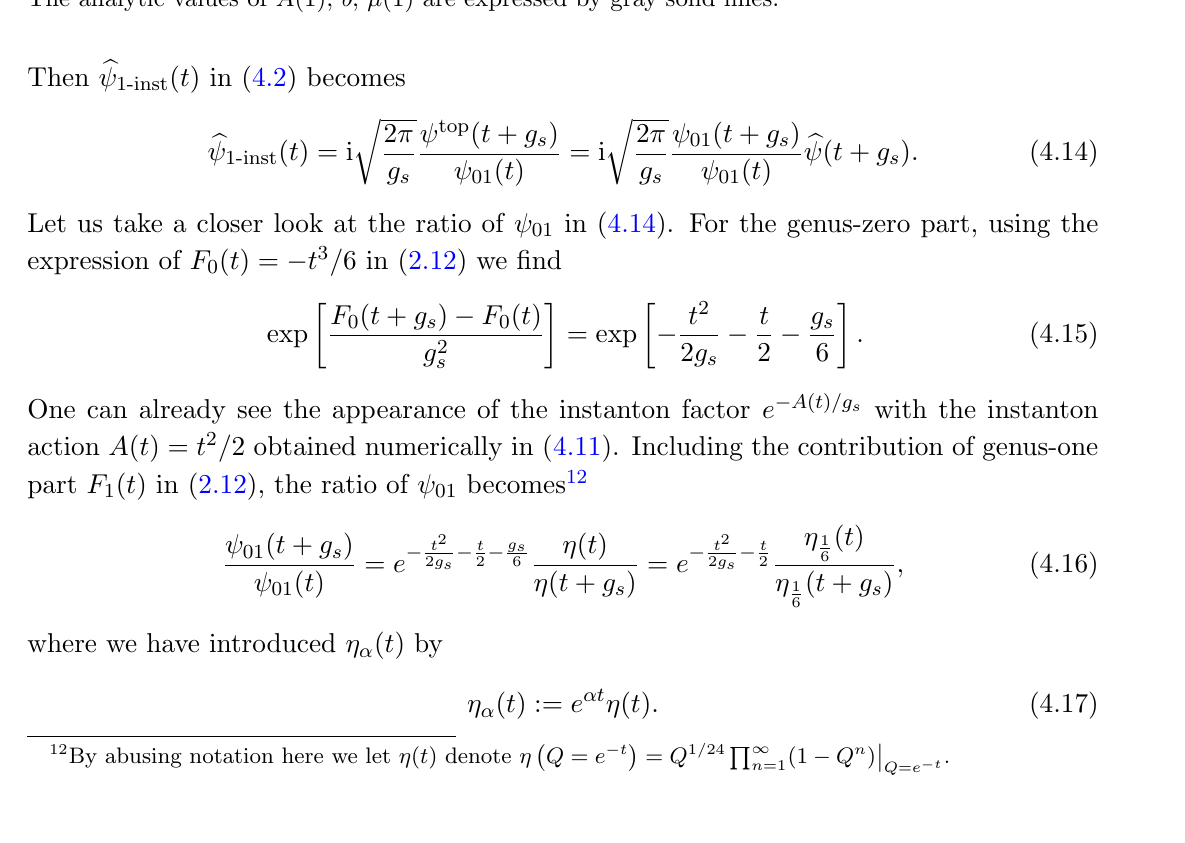
Figure 2 . Plots of sequences A m ; b m ; (cid:22) m at t = 1. Red points represent the original sequences, while blue and green points respectively represent their (cid:12)rst and second Richardson transforms. The analytic values of A (1) ; b; (cid:22) (1) are expressed by gray solid